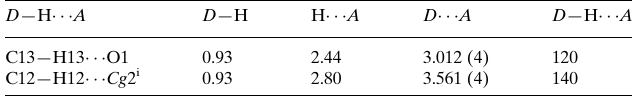
Hydrogen-bond geometry (A˚ , (cid:2) ). Cg 2 is the centroid of C1–C6